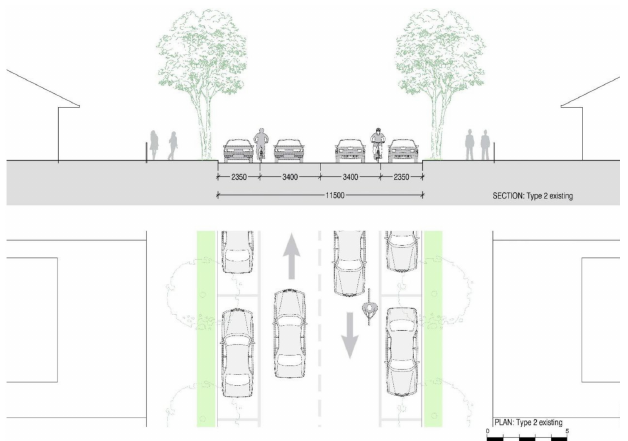
Figure 6. Section and plan drawings showing a ‘Type 2’ existing street configuration with 11.5 m or above street roadway width, 2.35 m parking spaces on either side of the streets and two-way single traffic lanes of 3.4 m width to accommodate 50–60 km/h speed